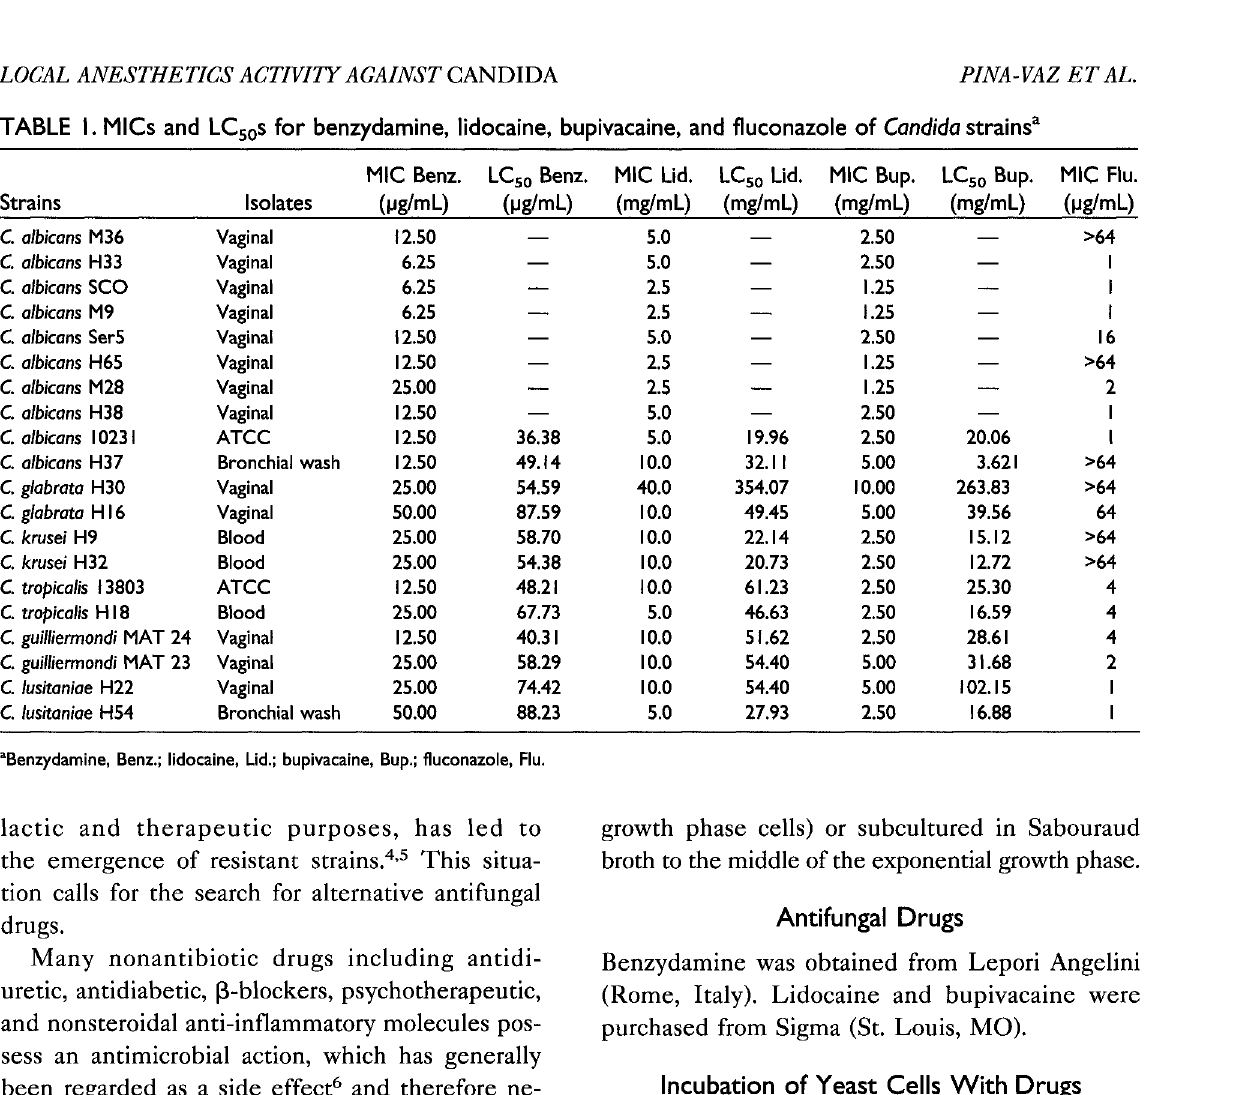
TABLE I. MICs and LCs0s for benzydamine, lidocaine, bupivacaine, and fluconazole of Candida strains